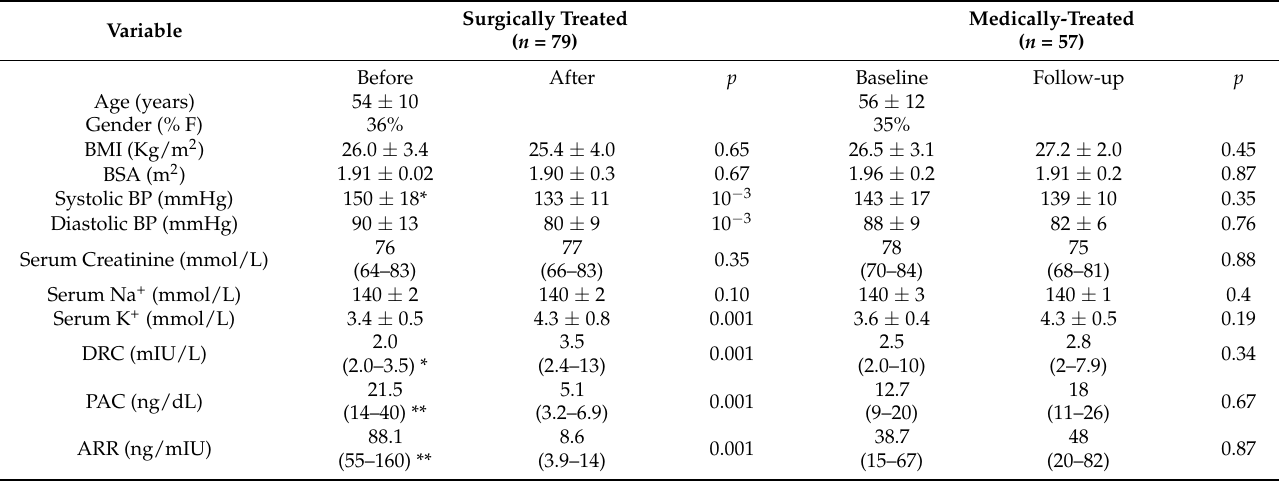
Table 1. Demographic and clinical features at baseline and after surgical or medical-treatment of the PA patients. Variable